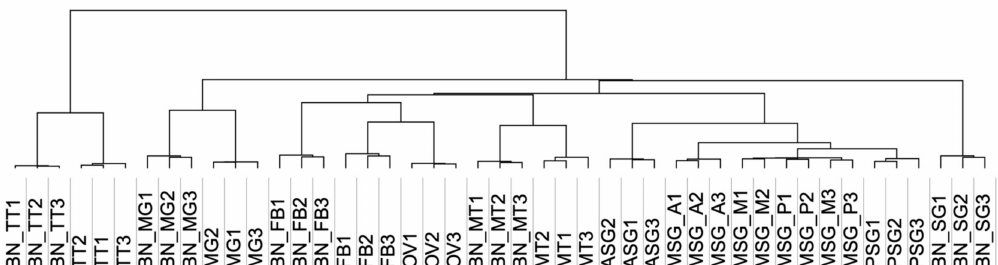
Figure 4. Hierarchical clustering of expression data in 45 samples of transcripts showing a tpm value > 30 in at least one sample. Abbreviations that start with “BN” indicate samples collected in a previous study [20–22]. The numbers added to the abbreviations mean biological